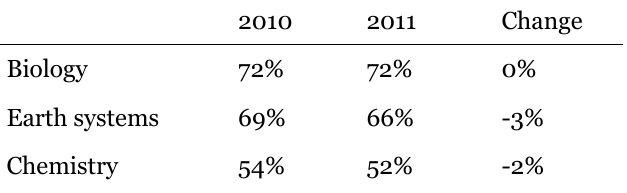
Statewide Changes in CRT Scores in Biology, Earth Systems, and Chemistry 2010–2011